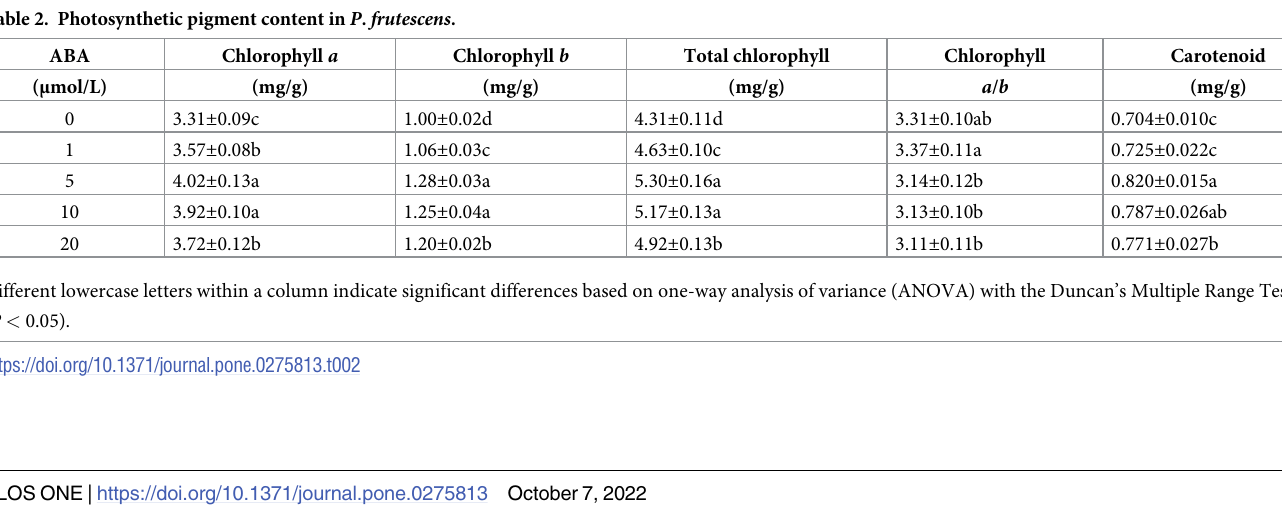
(Table 2). Administration of 5 μ mol/L ABA increased the chlorophyll a , chlorophyll b , total